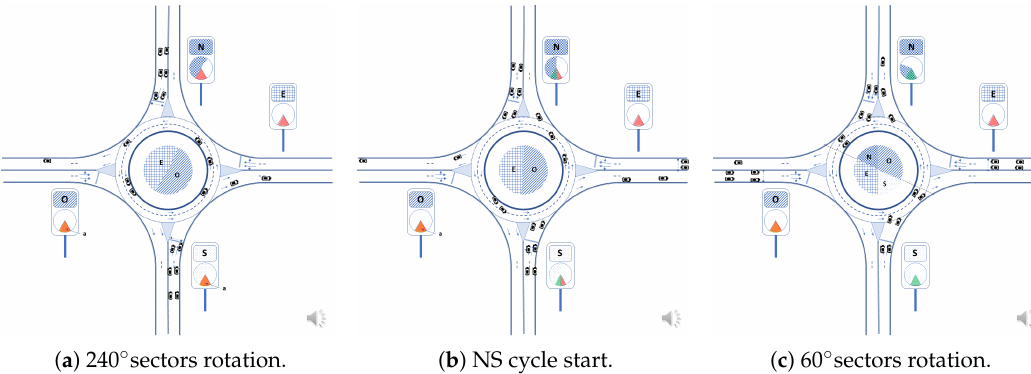
Figure 10. East-West (EW) end of cycle and start of a new NS cycle. ( a , b ) show the completion of the EW cycle. ( b ) shows the start of the priority period for the NS accesses. In ( c ) NS entries are